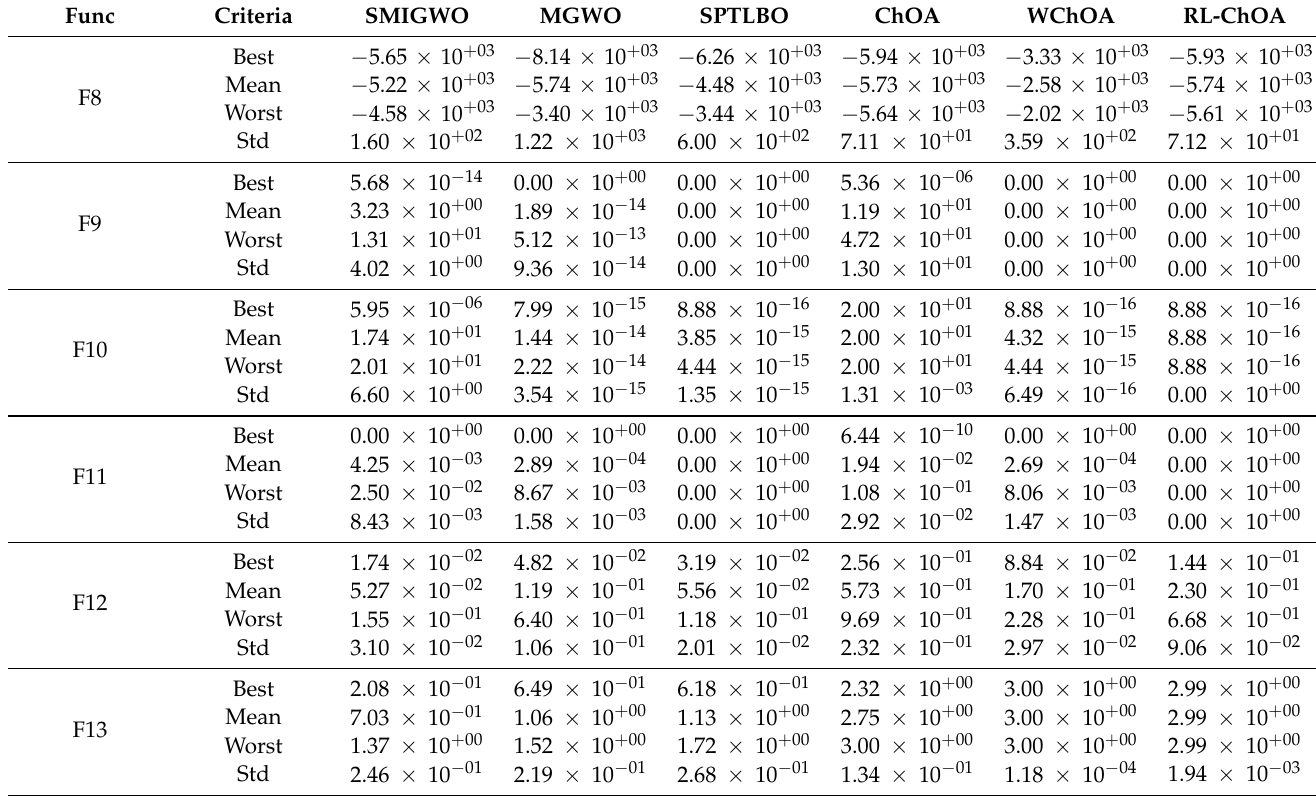
Table 3. Results of multi-modal benchmark functions.